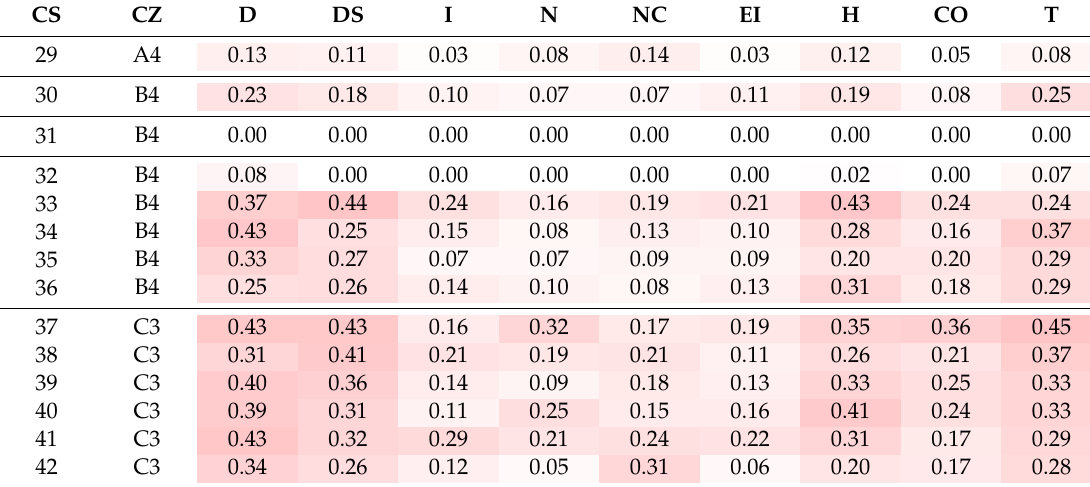
Table 5. Average values of health symptoms in case studies with open windows. Legend: Case study (CS), Climate zone (CZ), Dizziness (D), Dry Skin (DS), Itchiness (I), Nausea (N), Nasal congestion